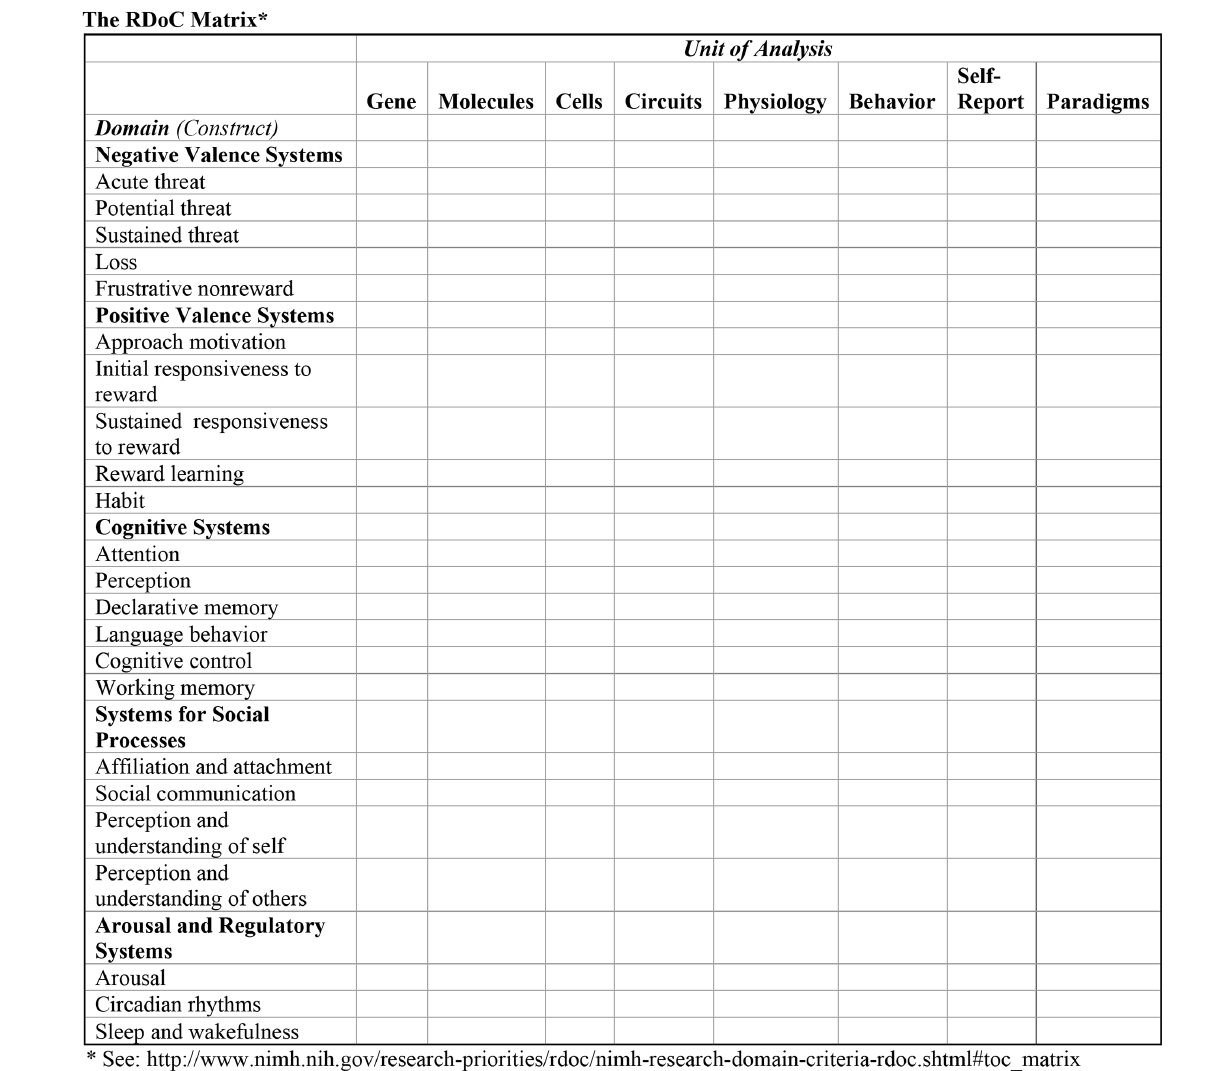
FIGURE 1 |The NIMH RDoC framework organized as a 2 × 2 matrix with rows for broad biobehavioral domains that group together specific constructs and columns representing levels of analysis, units, or types of data. Neural circuitry is the central level of analysis on the assumption that behavioral and experiential manifestations of